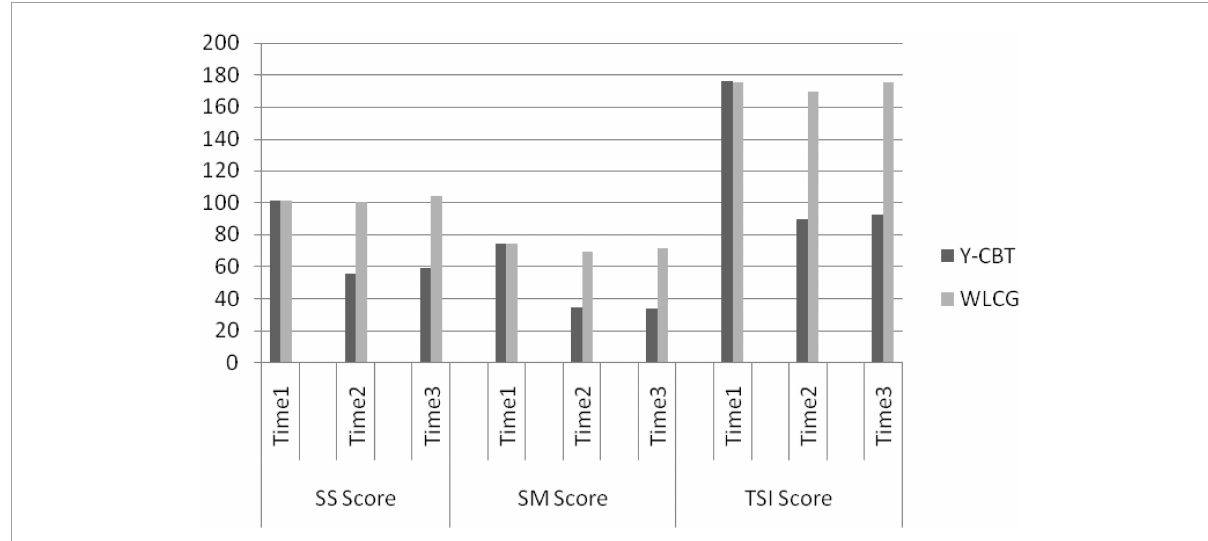
FIGURE6 Interaction effect of Time and intervention on Participants’ SS, SM, and TSI scores on the three